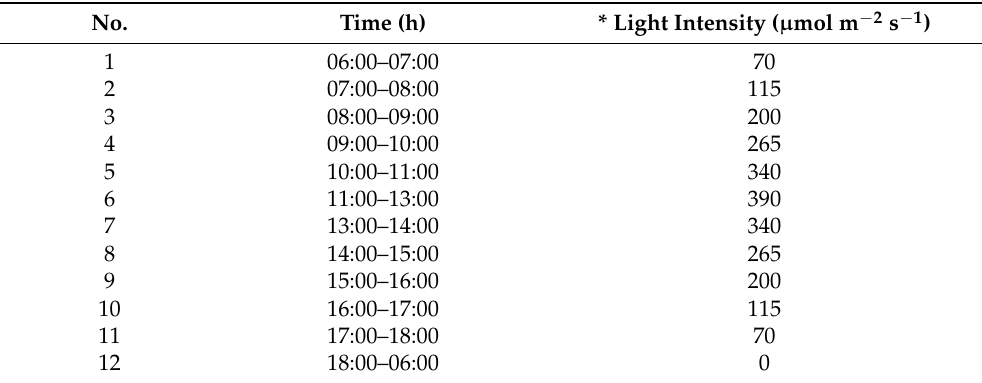
Table 5. Temperature, humidity and light intensity control data in the growth chamber (VRV.Corp., Ltd.,